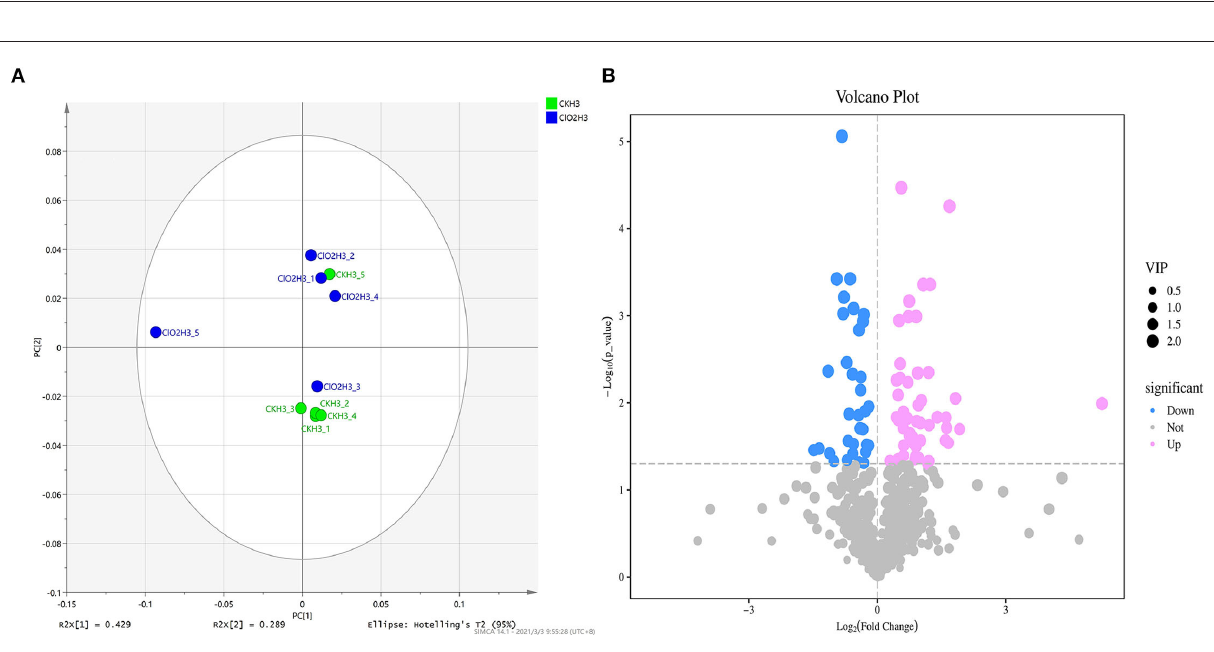
FIGURE 5 | Differential metabolite screening PCA analysis (A) and volcanic map (B)